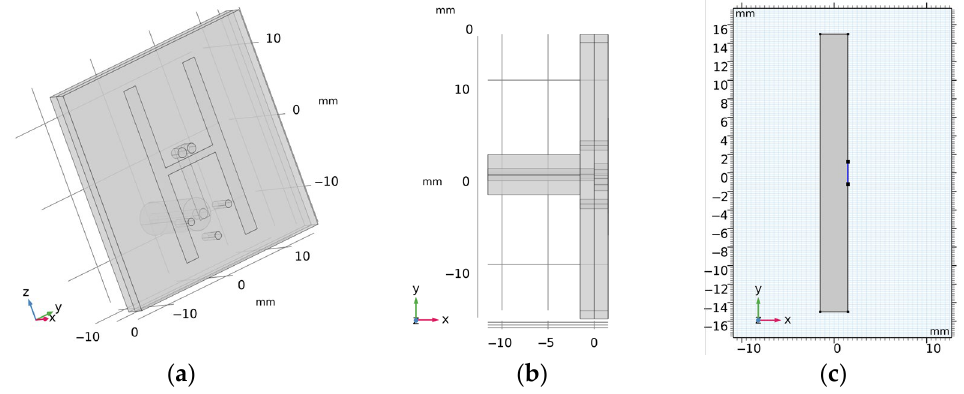
Figure 2. ( a , b ) is the 3D geometry of the antennas and ( c ) is the final 2D equivalent antenna model, where segments representing the slots (marked in blue) were changed to achieve maximum agreement to the measured transmission parameters within laboratory